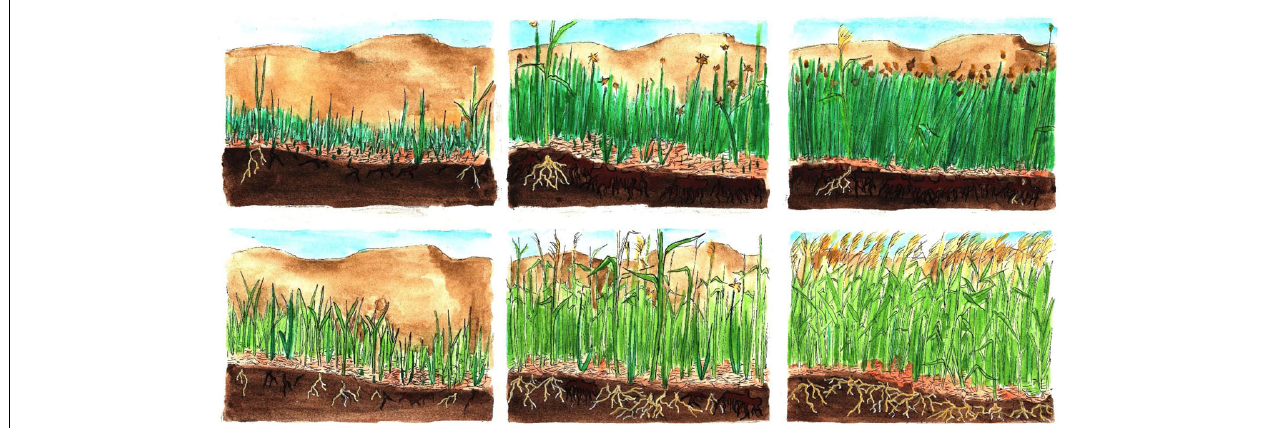
FIGURE 9 | The timing of when native seeds are sown can have a huge influence on plant community outcomes such as when you sow seeds early enough in the growing season to favor the dominance of a native species (in top scenario) vs. dominance of an unwanted invader (in bottom scenario). In the top scenario, non-dormant seeds of native species (here Schoenoplectus americanus , with darker green stems and darker brown roots and rhizomes) were sown early in the growing season to maximize native seedling emergence and plant establishment. Only 1–2 individuals of an invasive species (here Phragmites australis , with lighter green stems and beige roots and rhizomes) emerges; these individuals can be readily managed through spot spraying. In the bottom scenario, abundant P. australis seedlings emerge prior to the sowing of the target native species S. americanus . Once established, P. australis competitively excludes any S. americanus seedlings resulting in an invader monoculture. Watercolor by Corey